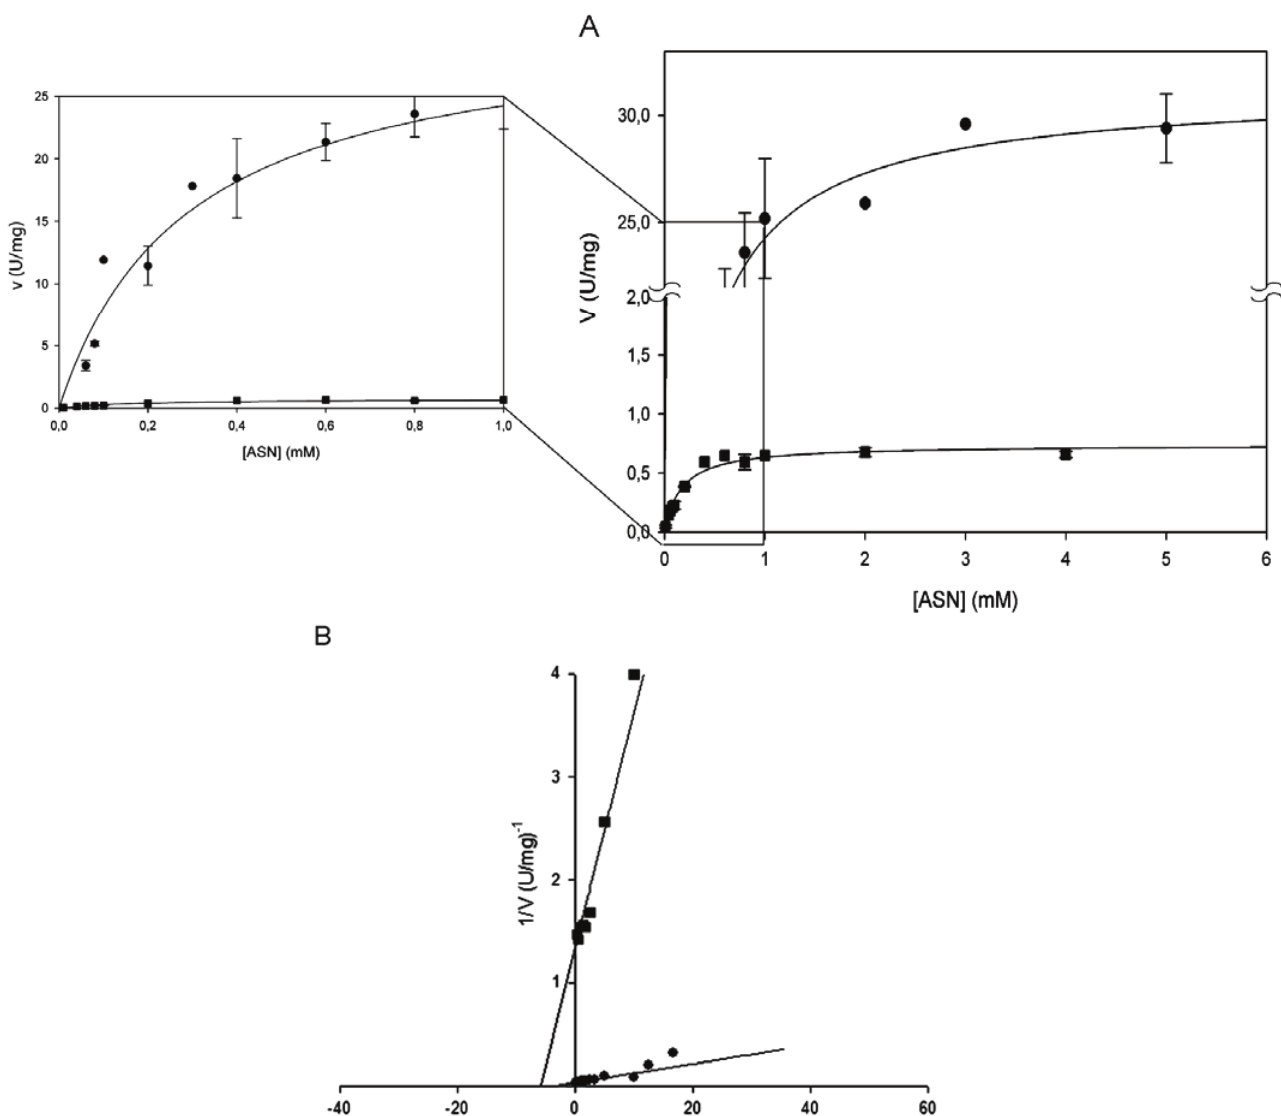
Figure 1. Steady-state kinetics of HpASNase E289A mutant as a function of L -asparagine ( L -ASN) compared to wild type enzyme. Activity dependence on substrate concentrations was measured at 37 °C in a reaction mixture containing 50 mM 4-(2-Hydroxyethyl)piperazine-1- ethanesulfonic acid (HEPES) buffer pH 7.5, 1 mM (cid:2)-ketoglutarate ((cid:2)-KG), 0.24 mM NADH, 20 U L -glutamate dehydrogenase and 0 to 10 mM L -ASN, in a final volume of 0.5 mL. Panel A represents data as Michaelis-Menten plot, with the off-set panel showing a detail of the plot corresponding to low L -ASN concentrations (0–1 mM). Panel B represents data as Linweaver-Burke plot. Wild type (cid:5), E289A mutant (cid:6). Data are represented as averages ( n (cid:7) 3) with error bars